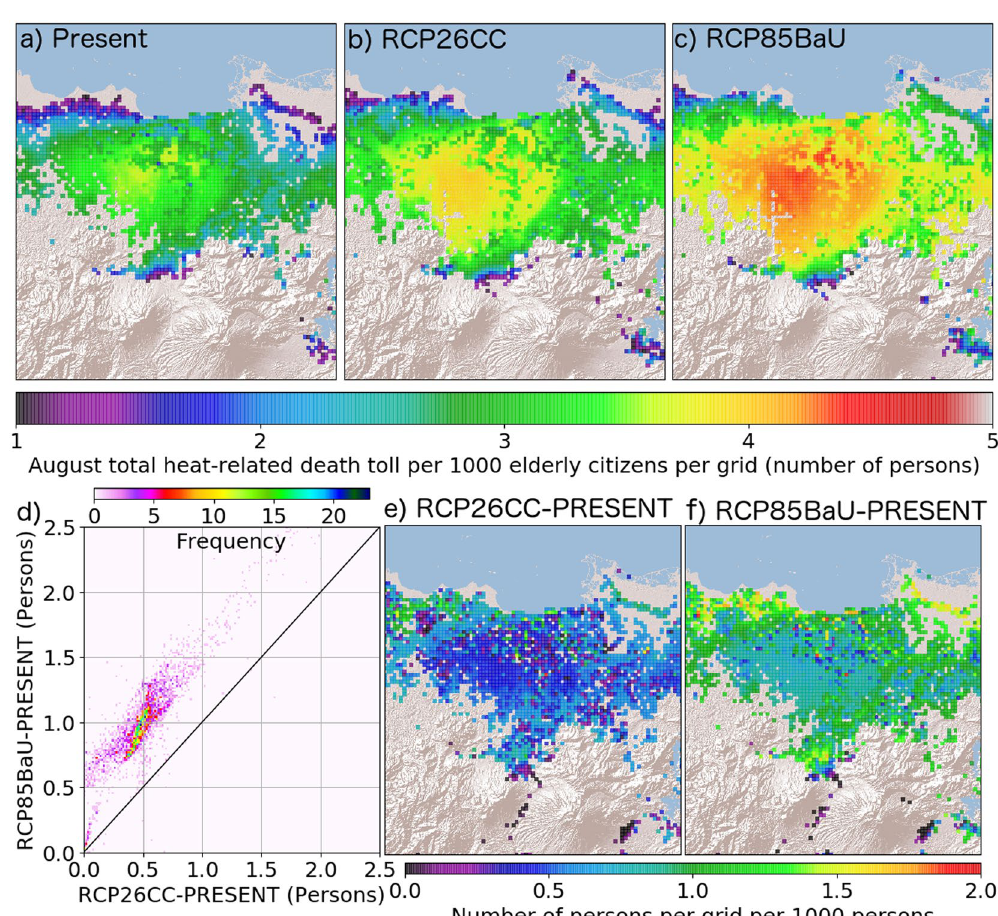
Figure 3. August total heat-related mortality count per 1000 elderly citizens per grid. ( a–c ) correspond to PRESENT, RCP26CC, and RCP85BaU cases. A 2-dimensional histogram ( d ) shows the changes in the death toll per 1000 elderly citizens per grid from 2010s to 2050s under RCP26CC ( e ) and RCP85BaU ( f )